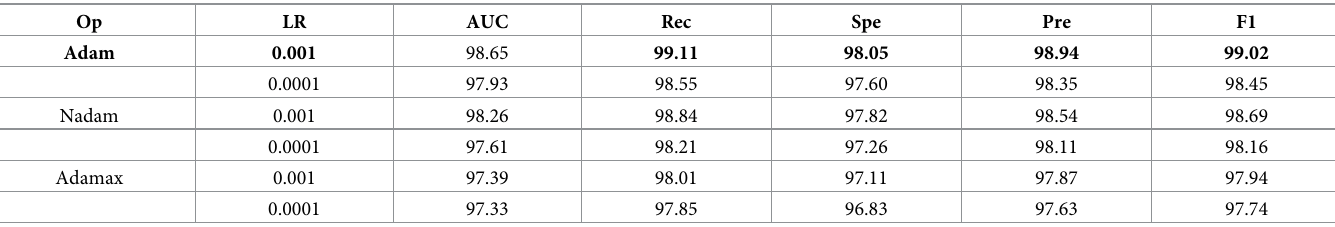
Table 13. AUC, Recall (Rec), Specificity (Spe), Precision (Pre) and F1-score (F1) for each of the optimizers corresponding to the learning rates. Op LR AUC Rec Spe F1 Adam Nadam